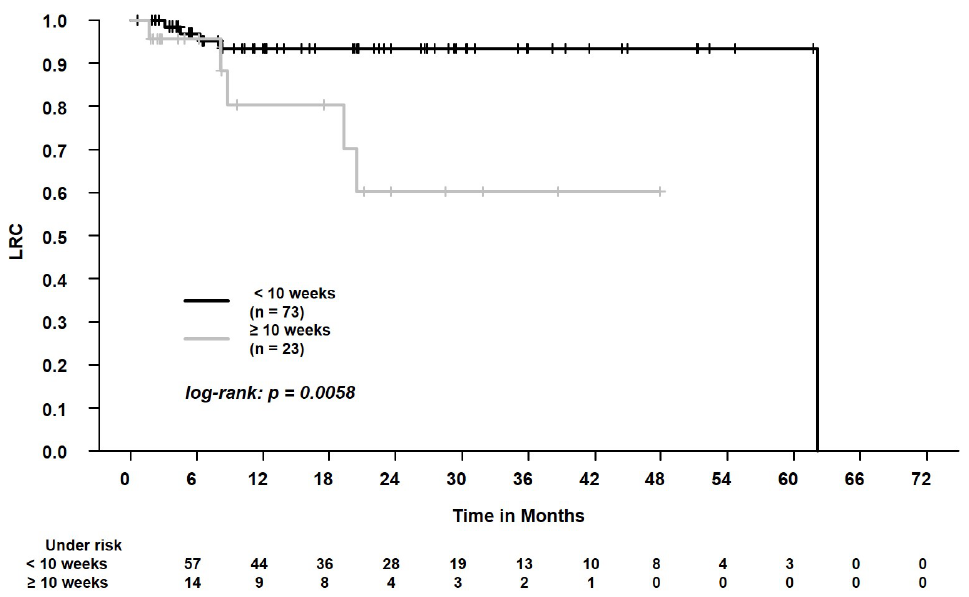
Figure 4. Locoregional control (LRC) in patients who were staged with positron emission tomography/computed tomography or chest CT scan < 10 weeks vs. ≥ 10 weeks before the start of SBRT. The 2-year LRC was 94.5% vs. 58.4%.